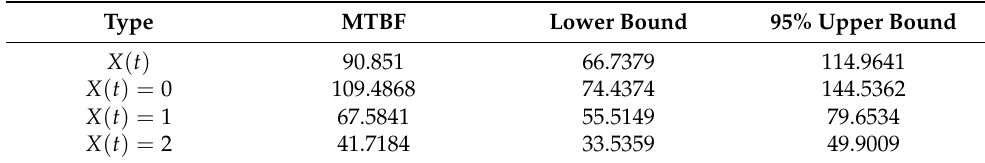
(cid:92) MTBF t and 95% confidence intervals at the failure points. Red lines represent the range of Figure 4. the 95% confidence intervals. Table 5. Estimations for MTBF and their 95% confidence